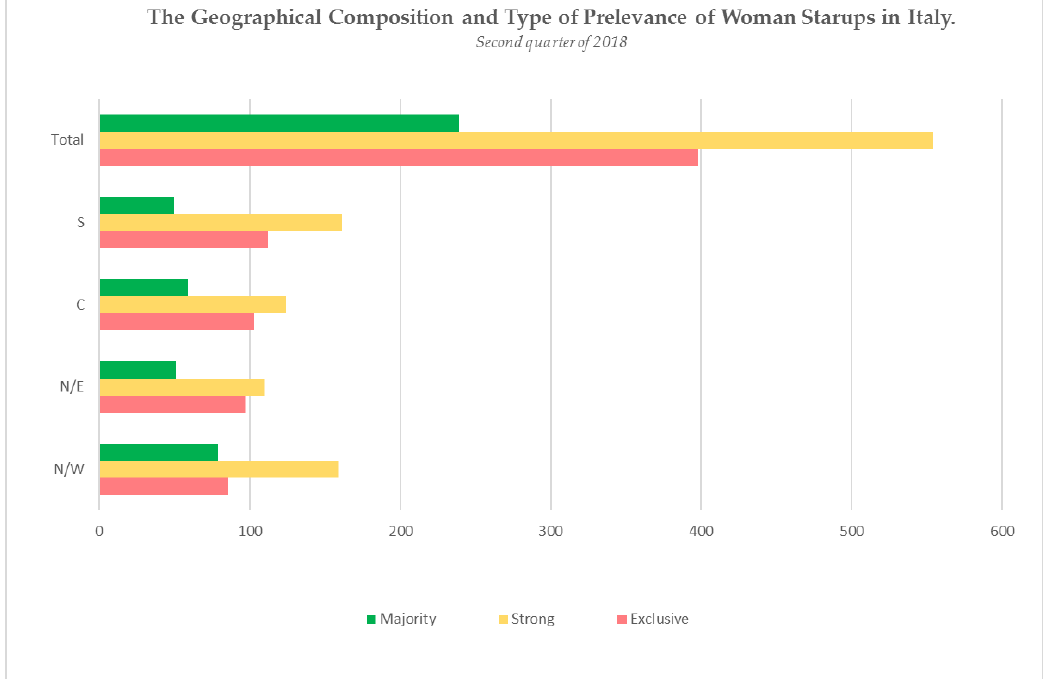
Figure 3. Composition, distribution, and type of relevance of woman startups in Italy.